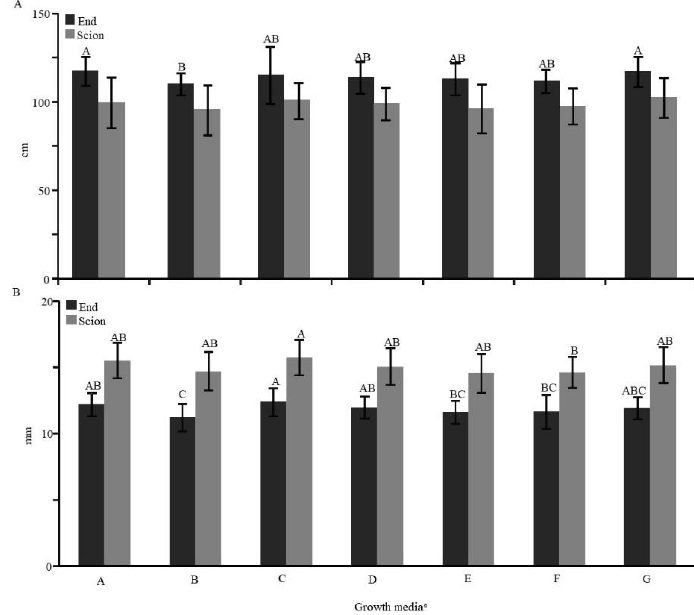
Figure 1. ( A ) Seedling height and ( B ) stem diameter at soil level measured on rootstocks in various growing media just before grafting and five months after grafting. For each parameter and period ANOVA and mean separation by Tukey’s HSD test ( p ≤ 0.01; bars represent standard deviation). a Growing media was 50% sandy soil + 50% of the following: A = black peat and perlite 1:1; B = biochar 1; C = black peat, perlite, and biochar 0.5:1:0.5; D = black peat and biochar 1:1; E = black peat, compost, and biochar 0.5:0.5:1; F = black peat, perlite, compost, and biochar 0.5:0.5:0.5:0.5; G = black peat and lapillus 1:1 (control, mixture adopted by the hosting nursery).